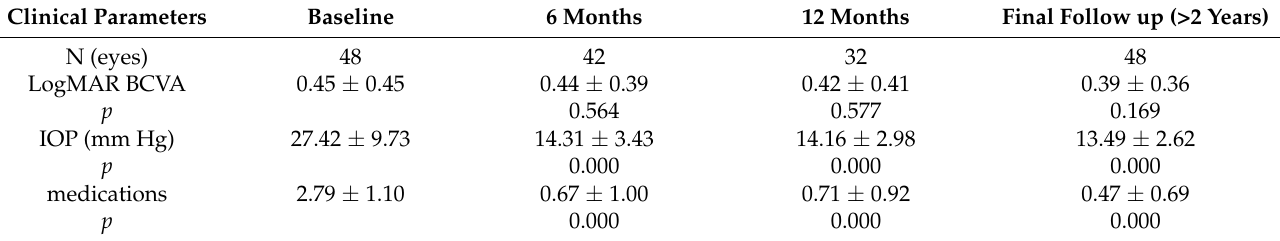
Table 2. Changes in clinical parameters after Ex-PRESS